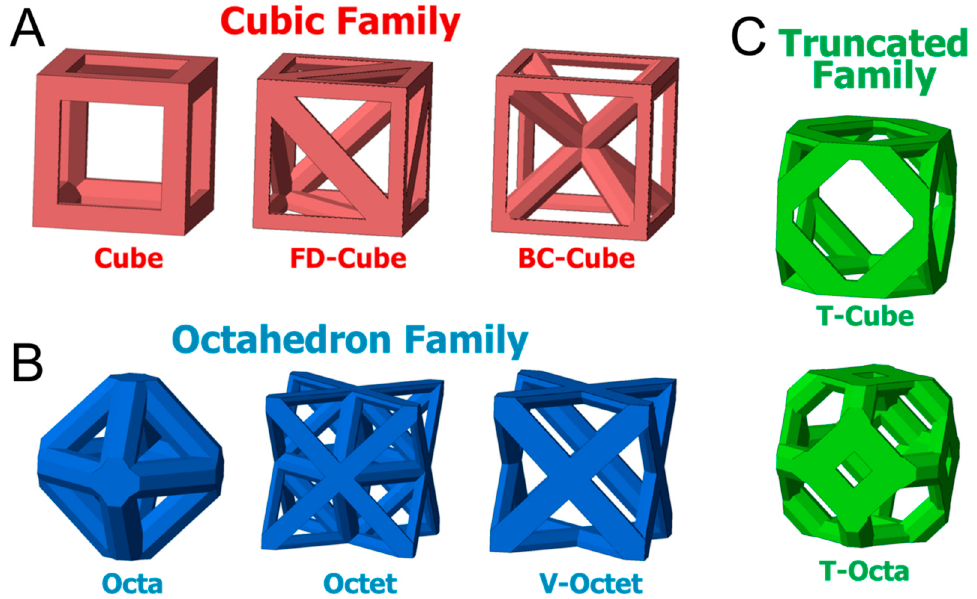
Figure 1. Potential lattice-based scaffold microstructures analyzed for bone tissue engineering (BTE) applications. Reprinted with permission from [37].